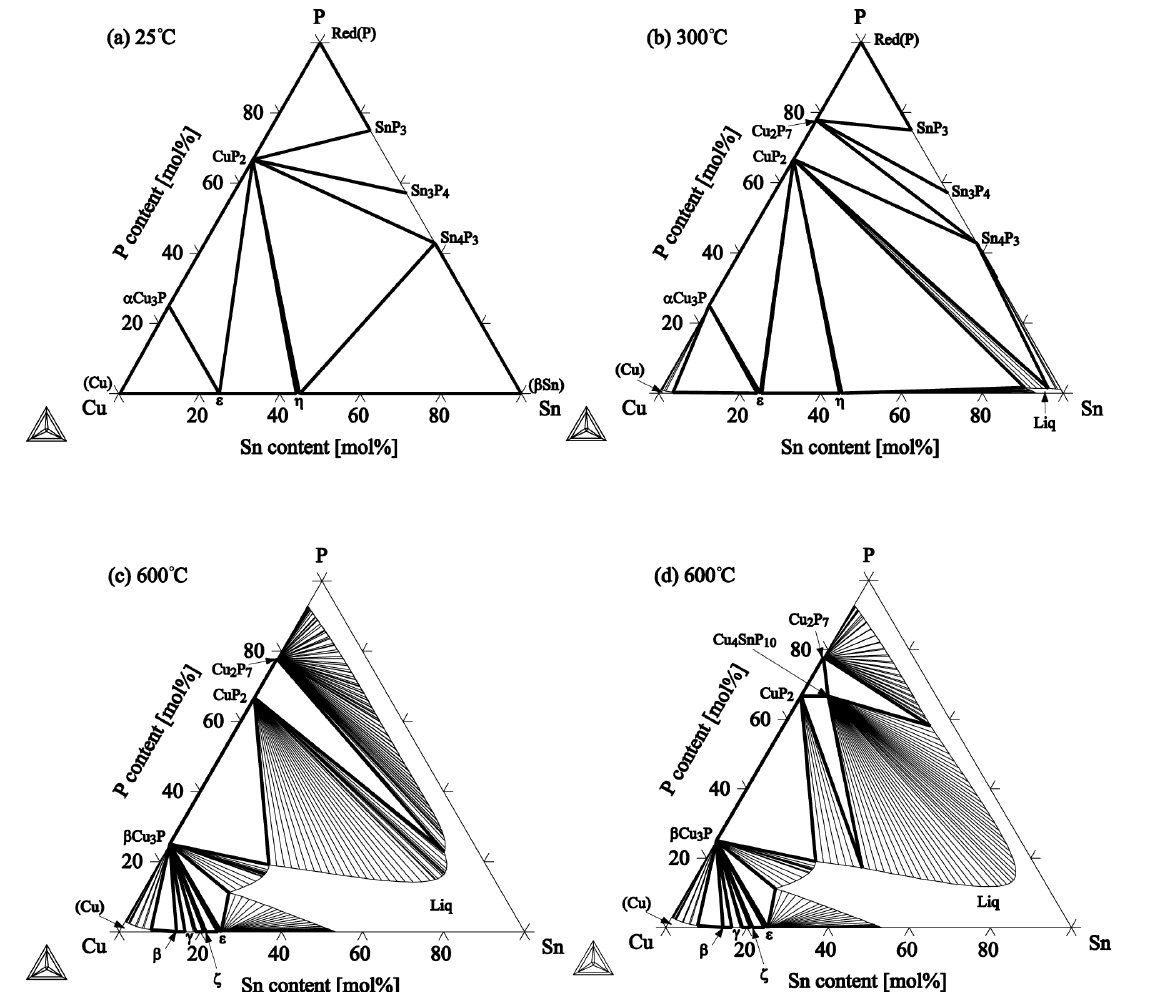
Figure 9. Calculated isothermal sections at (a) 25°C, (b) 300 °C, and (c) 600°C; (d) a hypothetical isothermal section diagram at 600°C, if the ternary compound Cu 4 SnP 10 would be thermodynamically more